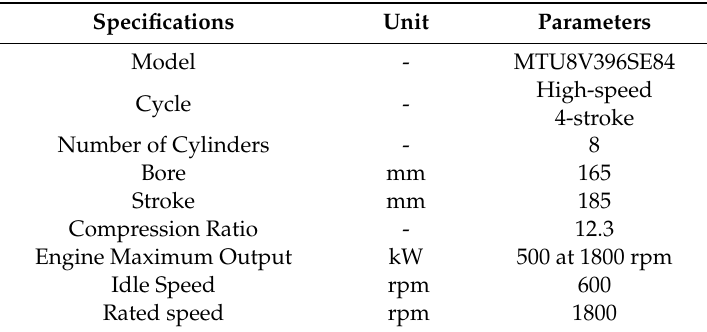
Table 1. Technical details of the marine diesel engine.